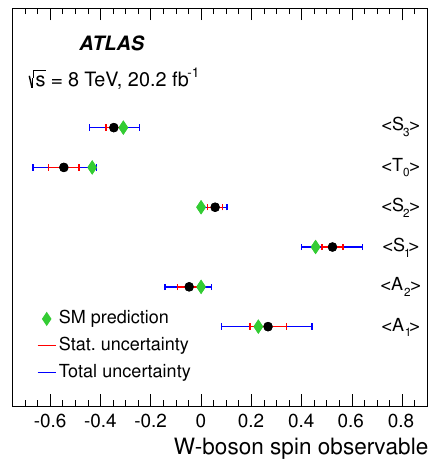
Figure 10. Summary of the measured values of the W -boson spin observables and comparison with the Standard Model